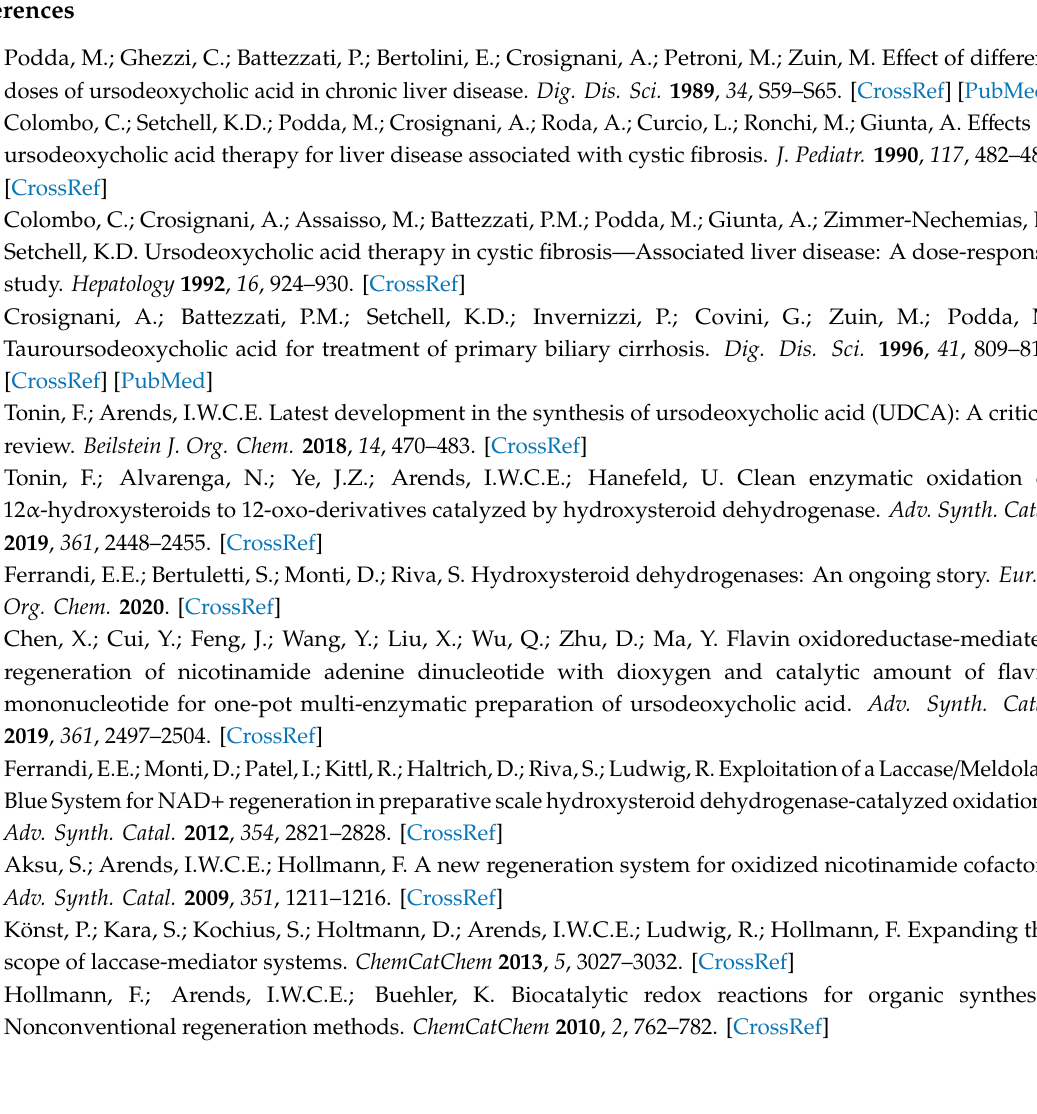
Figure S1. NGC chromatogram of Mt Lac purification by ion-exchange chromatography on Q-Sepharose column; Table S1. List of laccases used in the study; Table S2. Bioconversion of 10 mM CA to 12-oxo-CDCA in presence of 0.34 mg / mL Mt Lac, 0.013 mg / mL El 12 α -HSDH, 0.5 mM NAD + and 5 µ M of di ff erent mediators; Table S3. Activity of EvoCatal ADH screening kit towards hydroxysteroids and isopropanol; Table S4. Calculation of E-values and atom e ffi